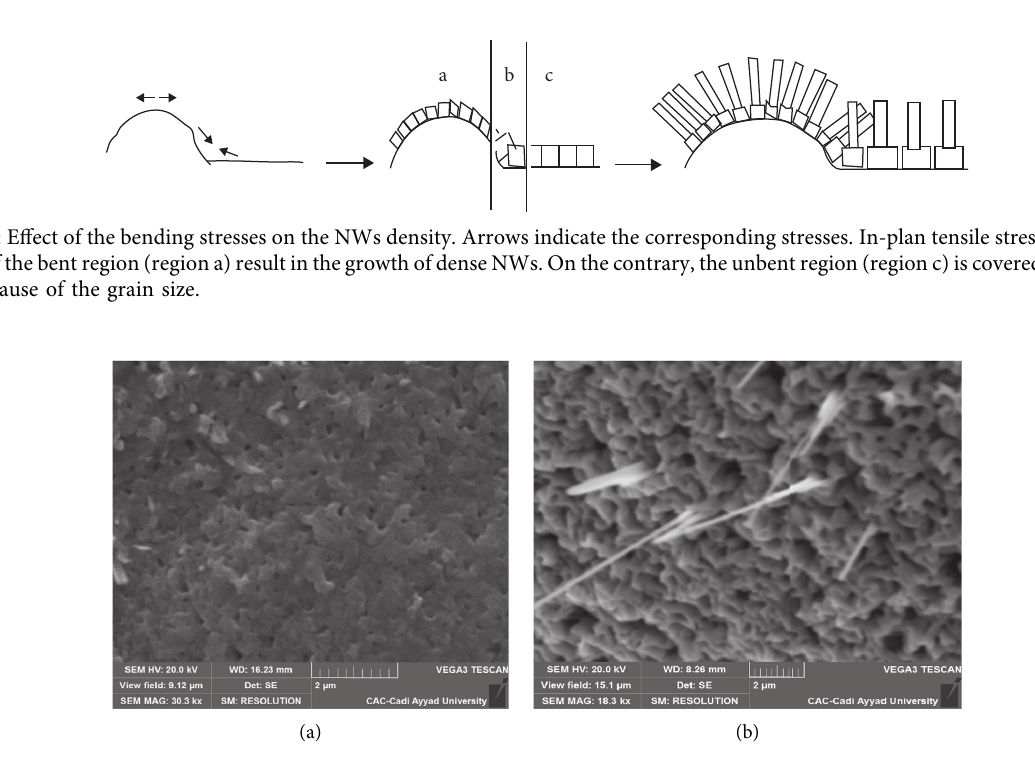
Figure 6: SEM image of nucleation sites for the samples synthesized at (a) 2 ° C/min after cleaning NWs by acetone and (b) 15 ° C/min. The slow heating results in more compact nucleation sites with low